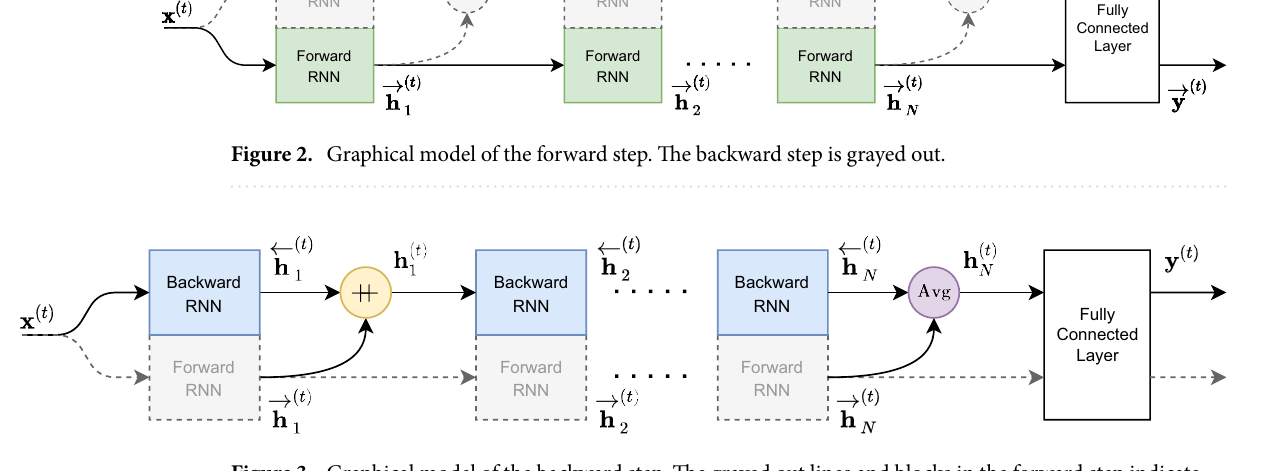
Figure 3. Graphical model of the backward step. The grayed out lines and blocks in the forward step indicate that this step is no longer necessary because the values are pre-computed in the forward step, and can be